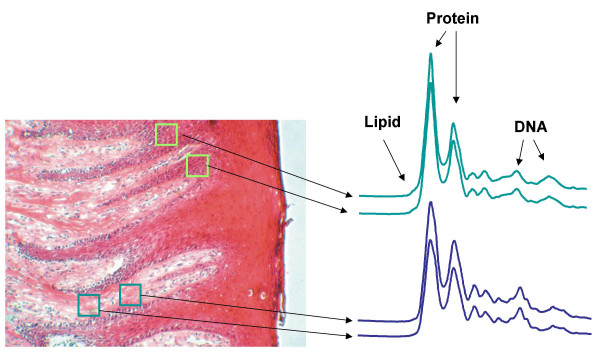
Comparison of periodontal tissues visualized by IR microspectroscopic mapping and by conventional H and E staining. Major periodontal tissue components (DNA, protein, and lipid), as determined by IR microspectroscopic mapping, are correlated with conventional H&E staining in a representative periodontal tissue section. IR spectra obtained from within the square boxes at different areas of the tissue section (periodontal epithelium and nearby connective tissue) are shown.